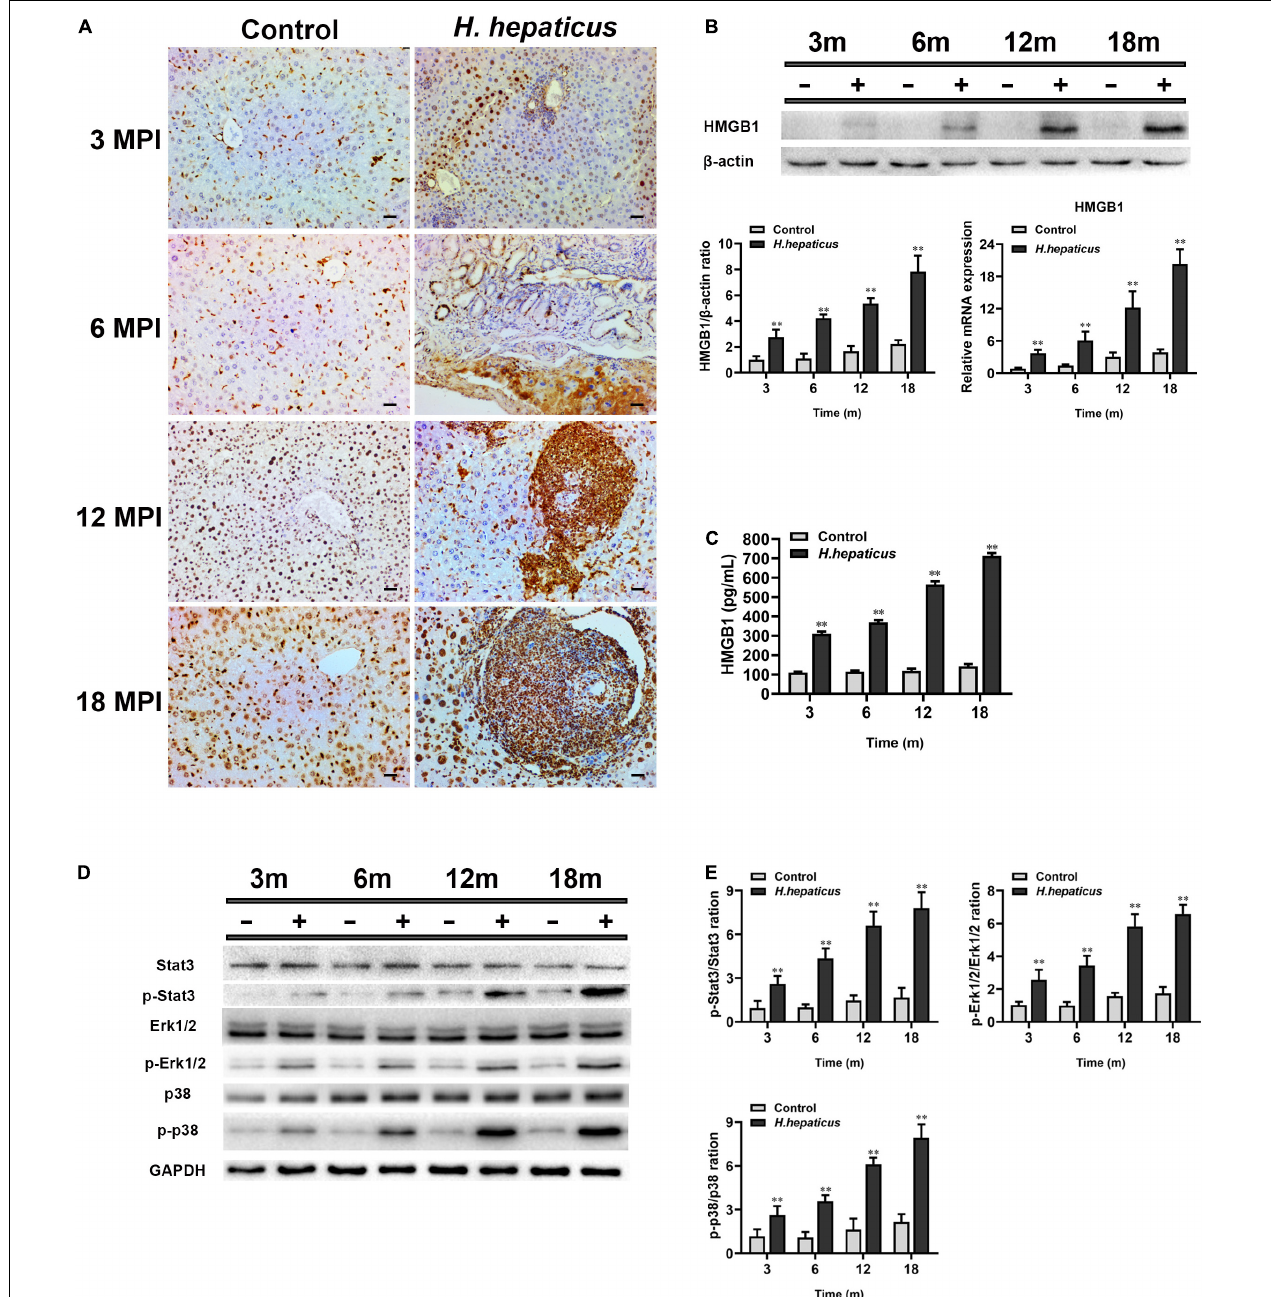
FIGURE 7 | Helicobacter hepaticus infection promoted activation and release of HMGB1. (A) Immumohistochemical (IHC) staining of HMGB1 images in the liver of H. hepaticus –infected and control mice at all time points (magnification, × 200). (B) The mRNA and protein expression level of HMGB1 was detected and analyzed. (C) The level of serum HMGB1 was detected and analyzed. (D,E) Western blot and densitometric analysis of Stat3, p-Stat3, Erk1/2, p-Erk1/2, p38, p-p38, and β -actin. Data are expressed as the means ± SD ( n = 5). ∗∗ p < 0.01 as compared to the control. Each group contained five